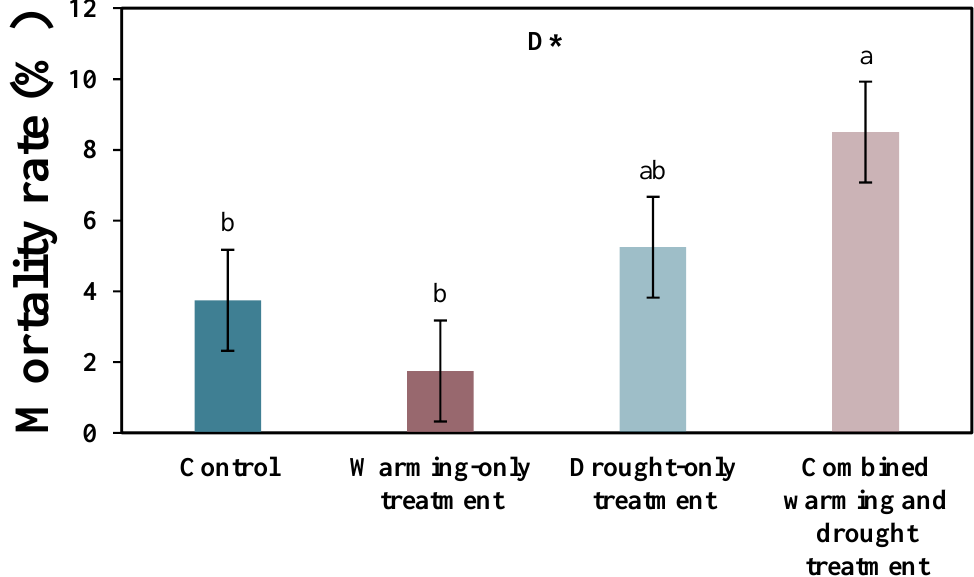
Figure 5. Mortality of Larix kaempferi seedlings in 2020. Bars with different letters are significantly different among treatments at p < 0.05. Error bars represent standard errors of the mean. The asterisk (*) indicates a significant difference in the drought treatment (* p < 0.05). D: drought